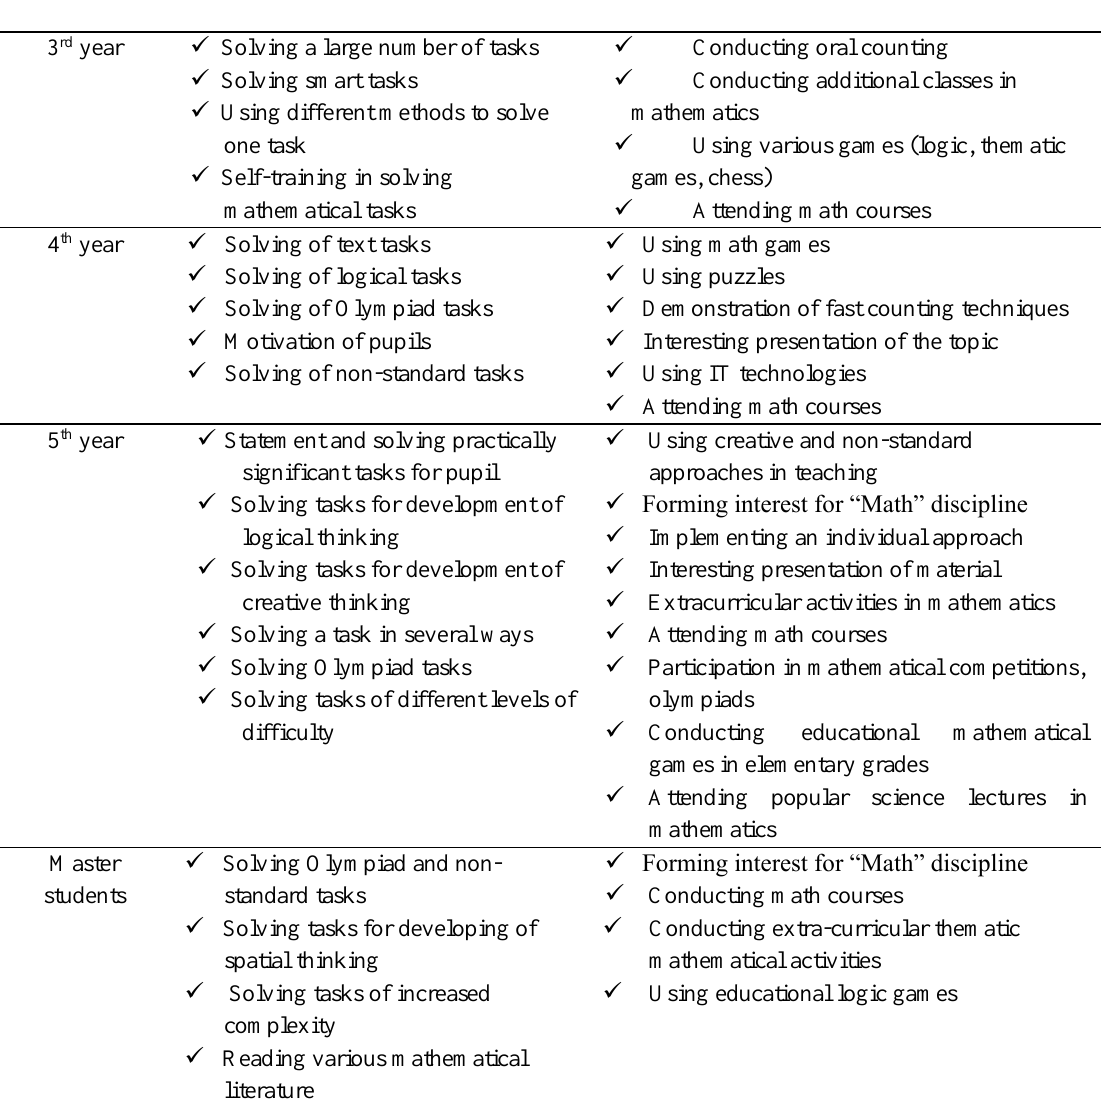
Table 5. Students 'answers to the question “How are mathematical abilities